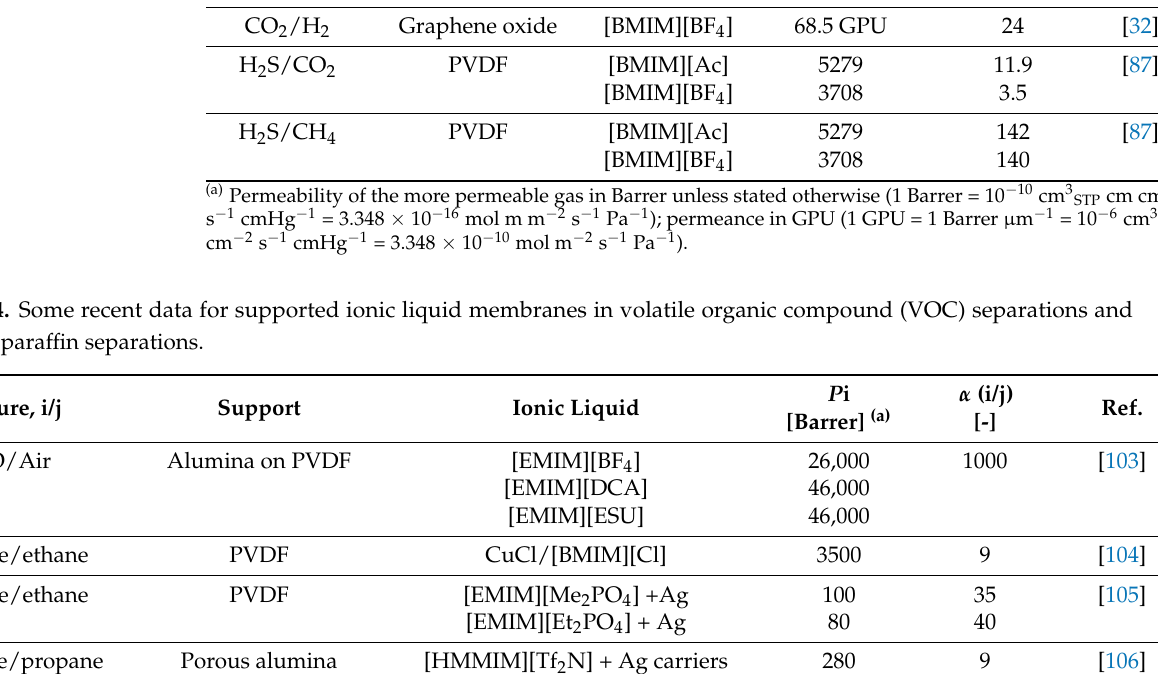
Table 3. Recent data for supported ionic liquid membranes in CO 2 /H 2 and H 2 S/CO 2 separations. Mixture, i/j